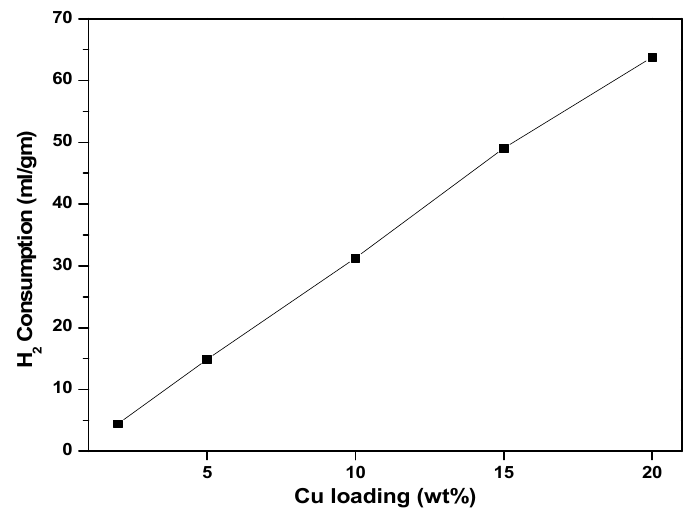
Figure 4. H 2 consumed against Cu loading.